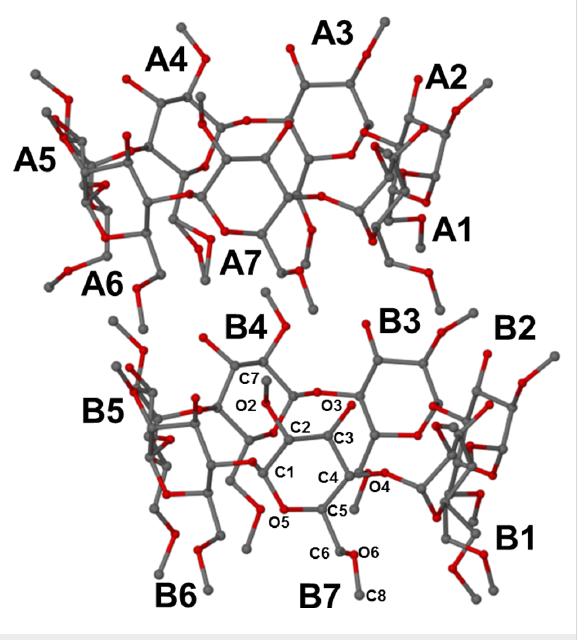
Figure 4: The host molecules in the asymmetric unit of DIMEB· 1 with the labelling of both residues and atoms indicated. H atoms are omitted for